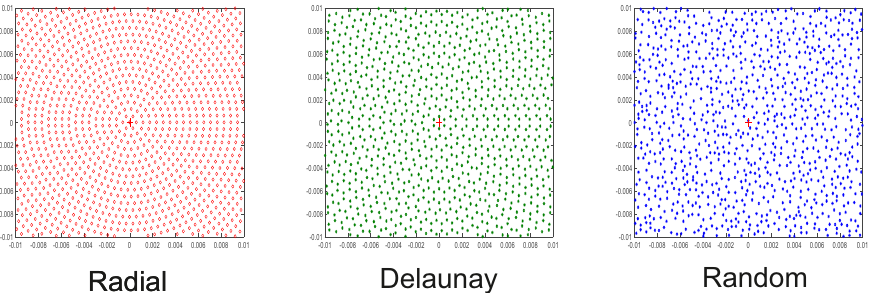
Figure 5. 2D Blast Explosion: Particle initializations. Radial distribution ( left ), Delaunay distribution ( center ), Random distribution ( right ).